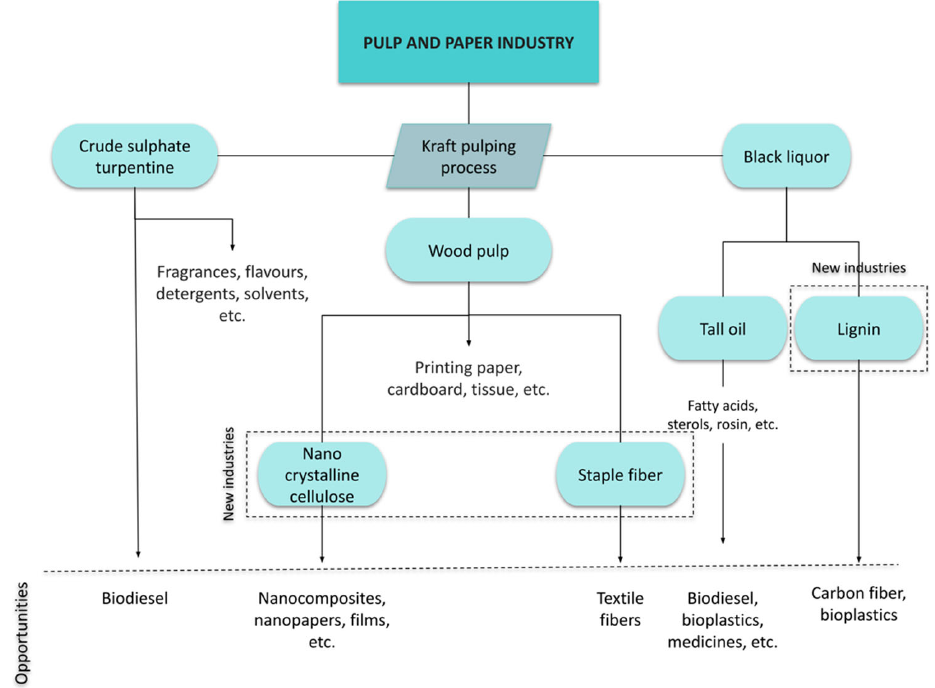
Figure 2. Main innovative products from the Brazilian planted tree pulp and paper industry, and potential new industries.